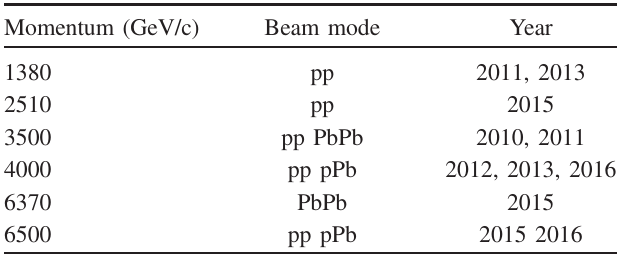
TABLE I. LHC operation energies with beam mode and corresponding